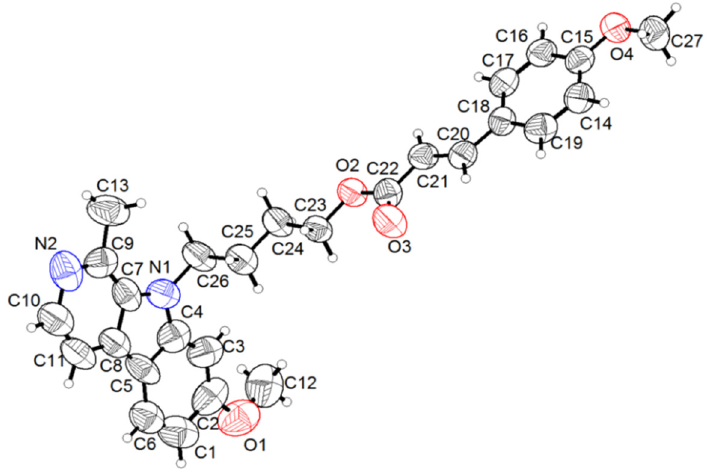
Figure 2. ORTEP diagram for compound 4a with ellipsoids set at 75% probability.